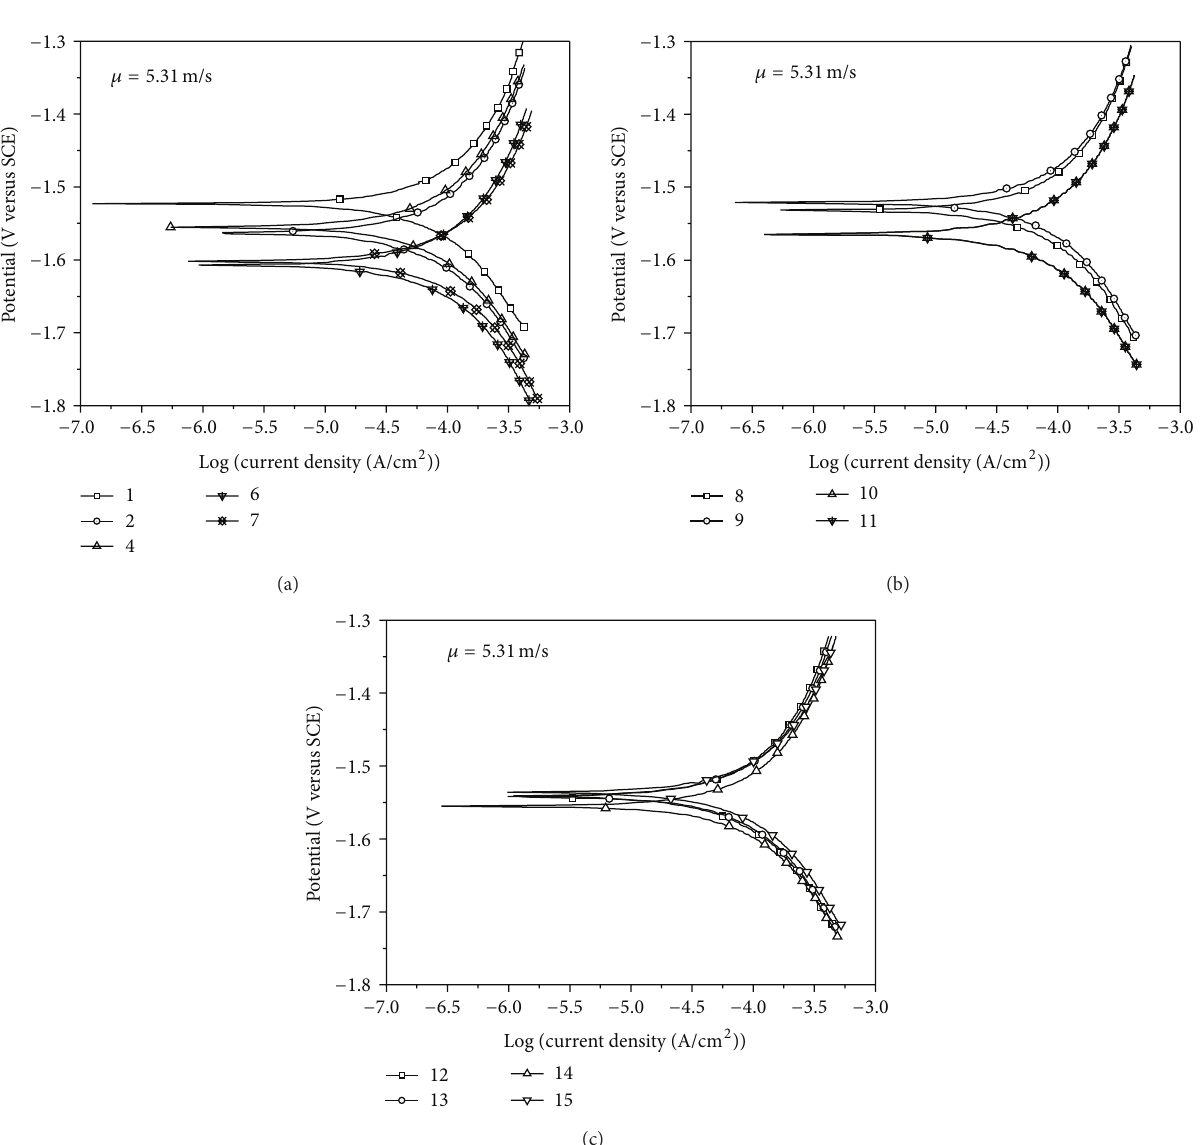
from analytical grade reagents and deionized water. The pH of the solution is